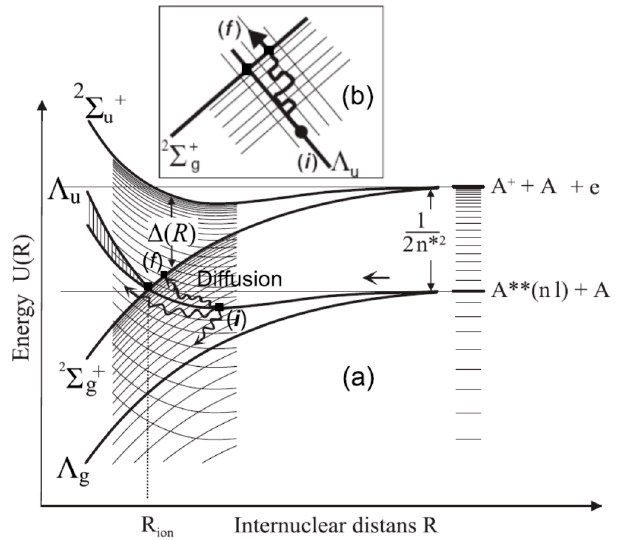
Figure 4. Mechanism of collisional ionization involving a Rydberg atom and an atom in normal state.